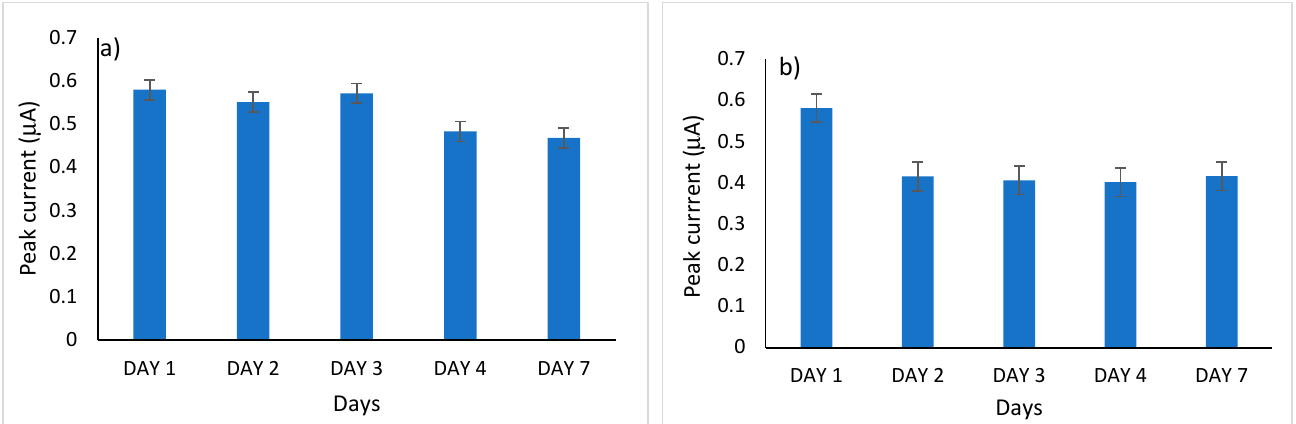
Figure 9. Stability of the sensors for a period of 7 days for: ( a ) TPP/rGO@Pd0 and ( b ) Fe(TPFPP)Cl/rGO@Pd0.